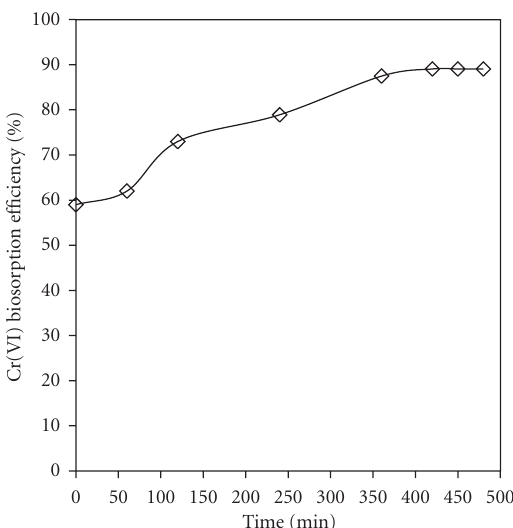
Figure 3: Cr(VI) biosorption (mg/g) by T. gamsii biomass from electroplating industrial waste diluted to final Cr(VI) concentration in the range from 100 to